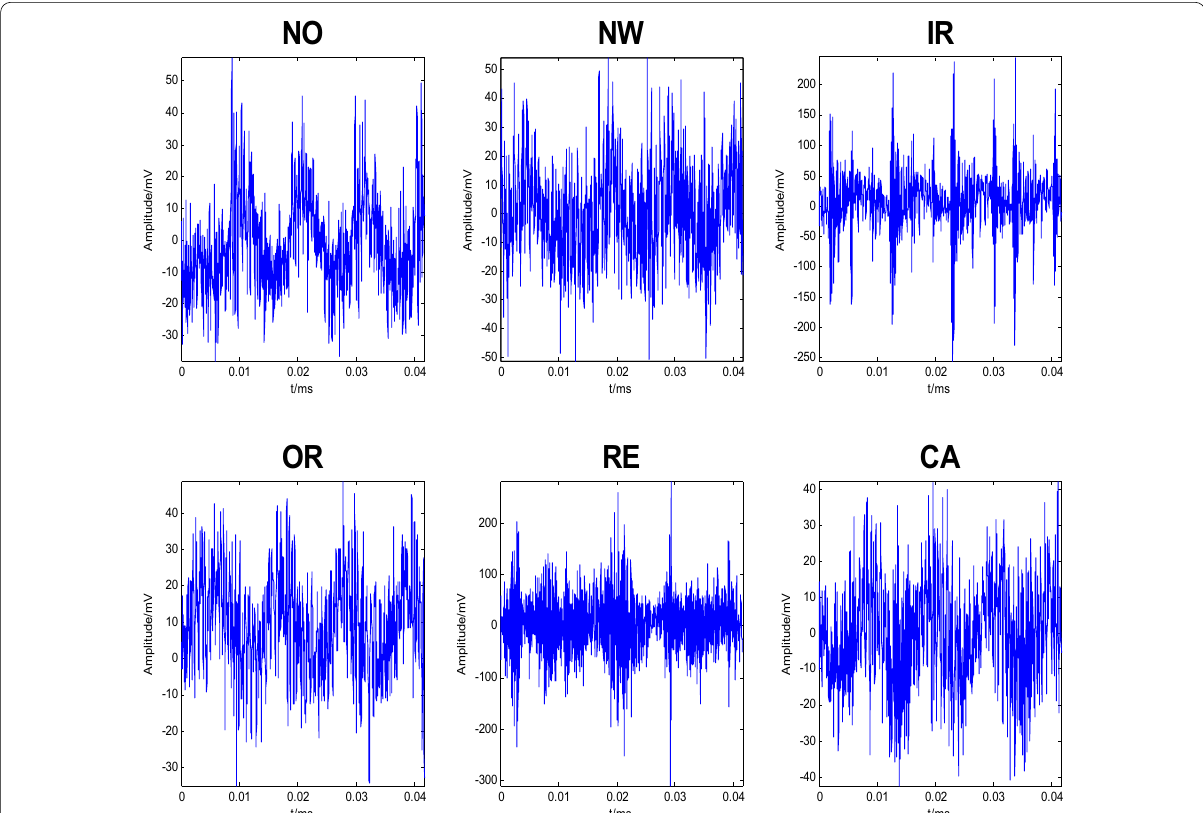
Figure 8 Typical time – domain vibration signals for the six different conditions of the first case study